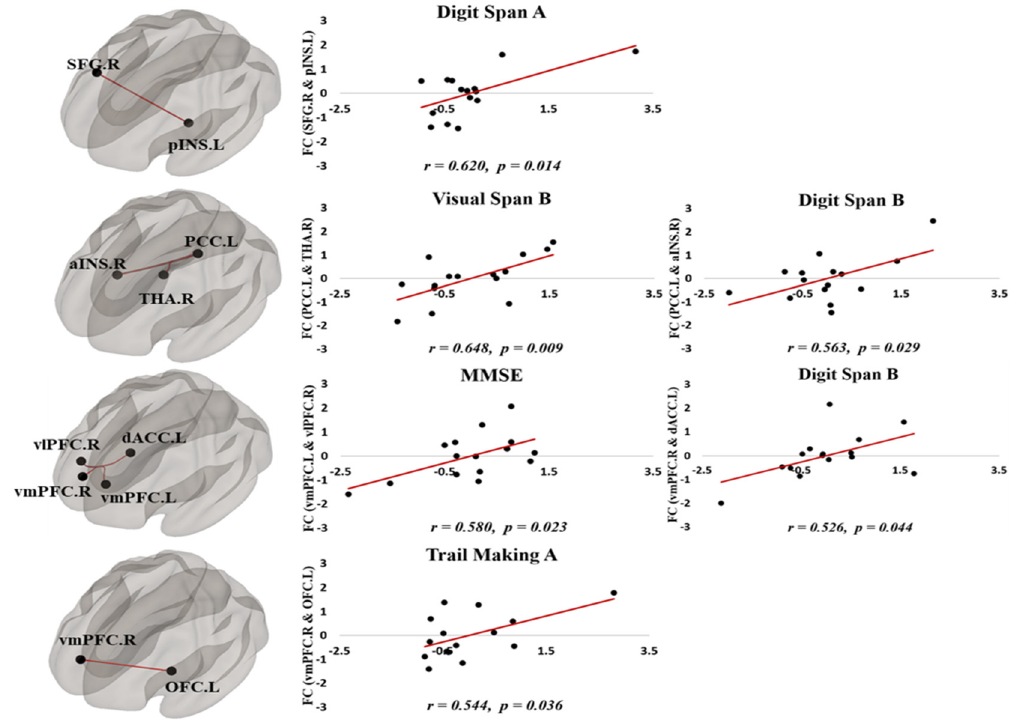
Figure 3. The functional connectivity among ROIs was associated with neurocognitive abilities after CCT training. In the partial correlation analysis, the connectivity between brain structures in core cognitive brain networks was positively correlated with neurobehavioral test scores.